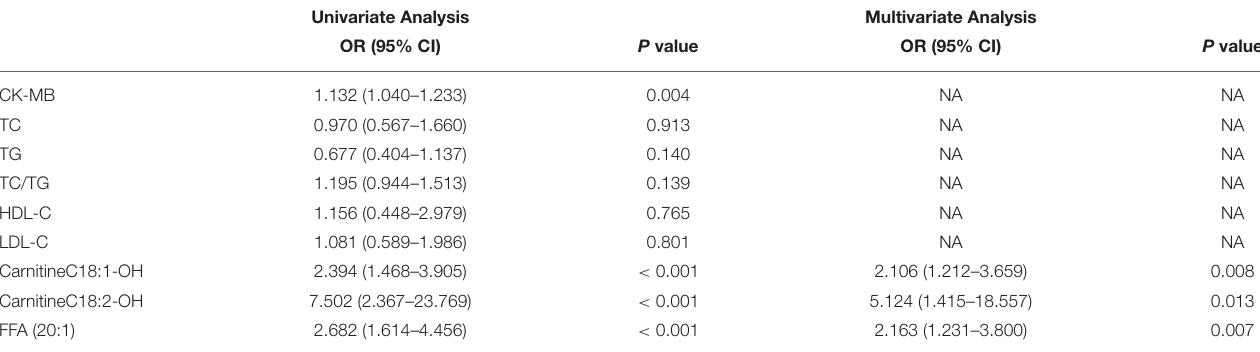
TABLE 2 | Univariate and multivariate logistic regression in discovery